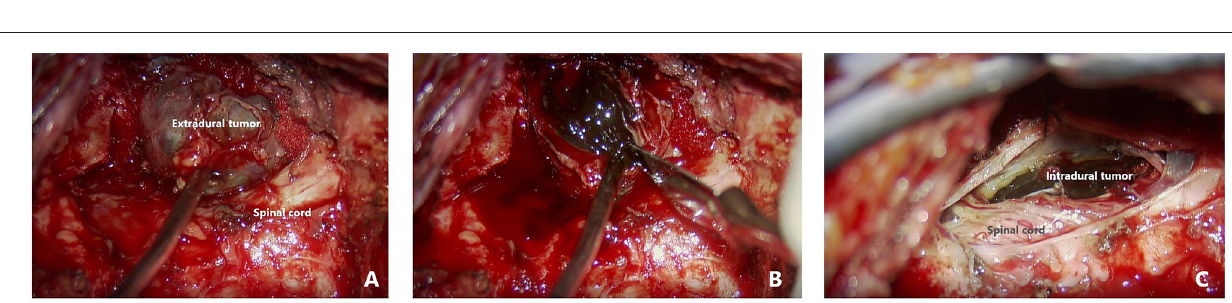
FIGURE 2 | Intraoperative findings ***. (A) Intraoperative view of the extradural portion of the tumor. (B) Opening the capsule to reveal a blackish tumor. (C) Intradural portion of the blackish tumor anterior to the cervical cord.